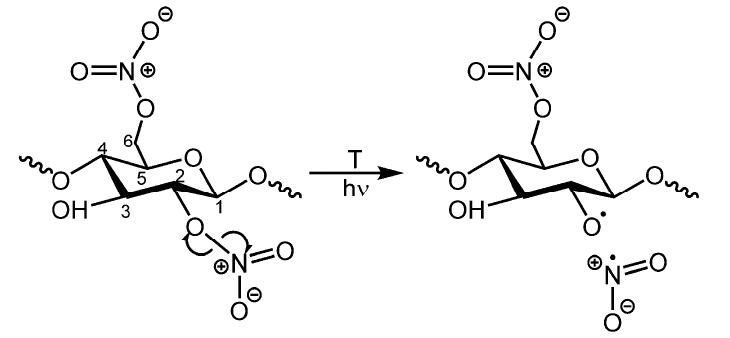
Figure 1. Scheme illustrating the initial homolysis of NO 2 groups in CN [7]. NO 2 groups can be attached to C2, C3 and C6 positions. attached to C2, C3 and C6